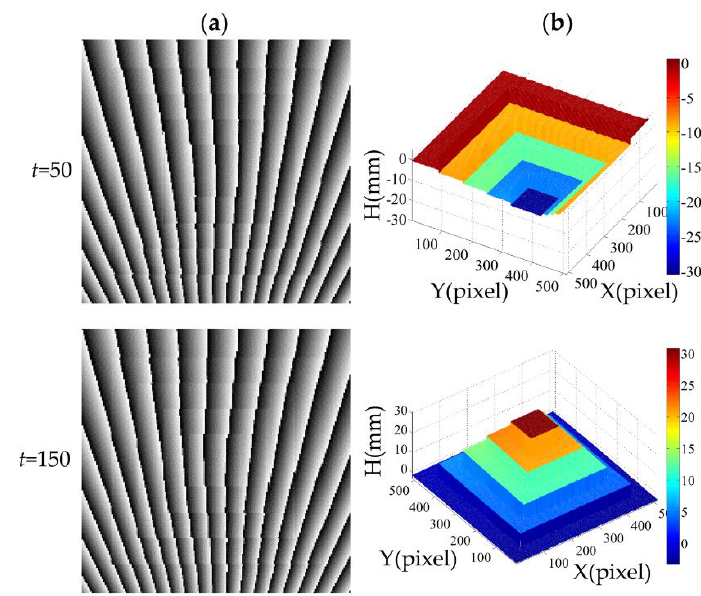
Figure 8. Simulation results of 2 different moments by TFTP. ( a ) Wrapped phase. ( b ) 3D reconstruction.